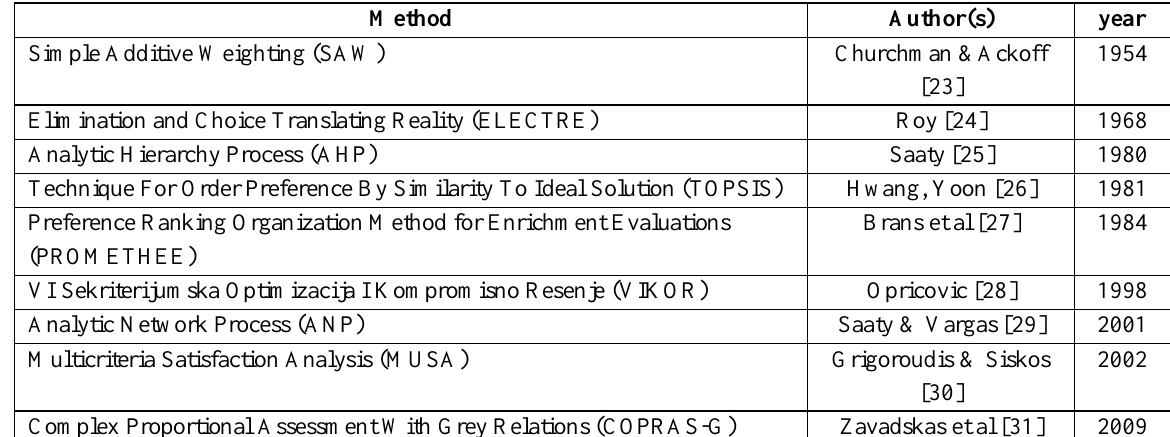
Table.1 . Summary of MADM